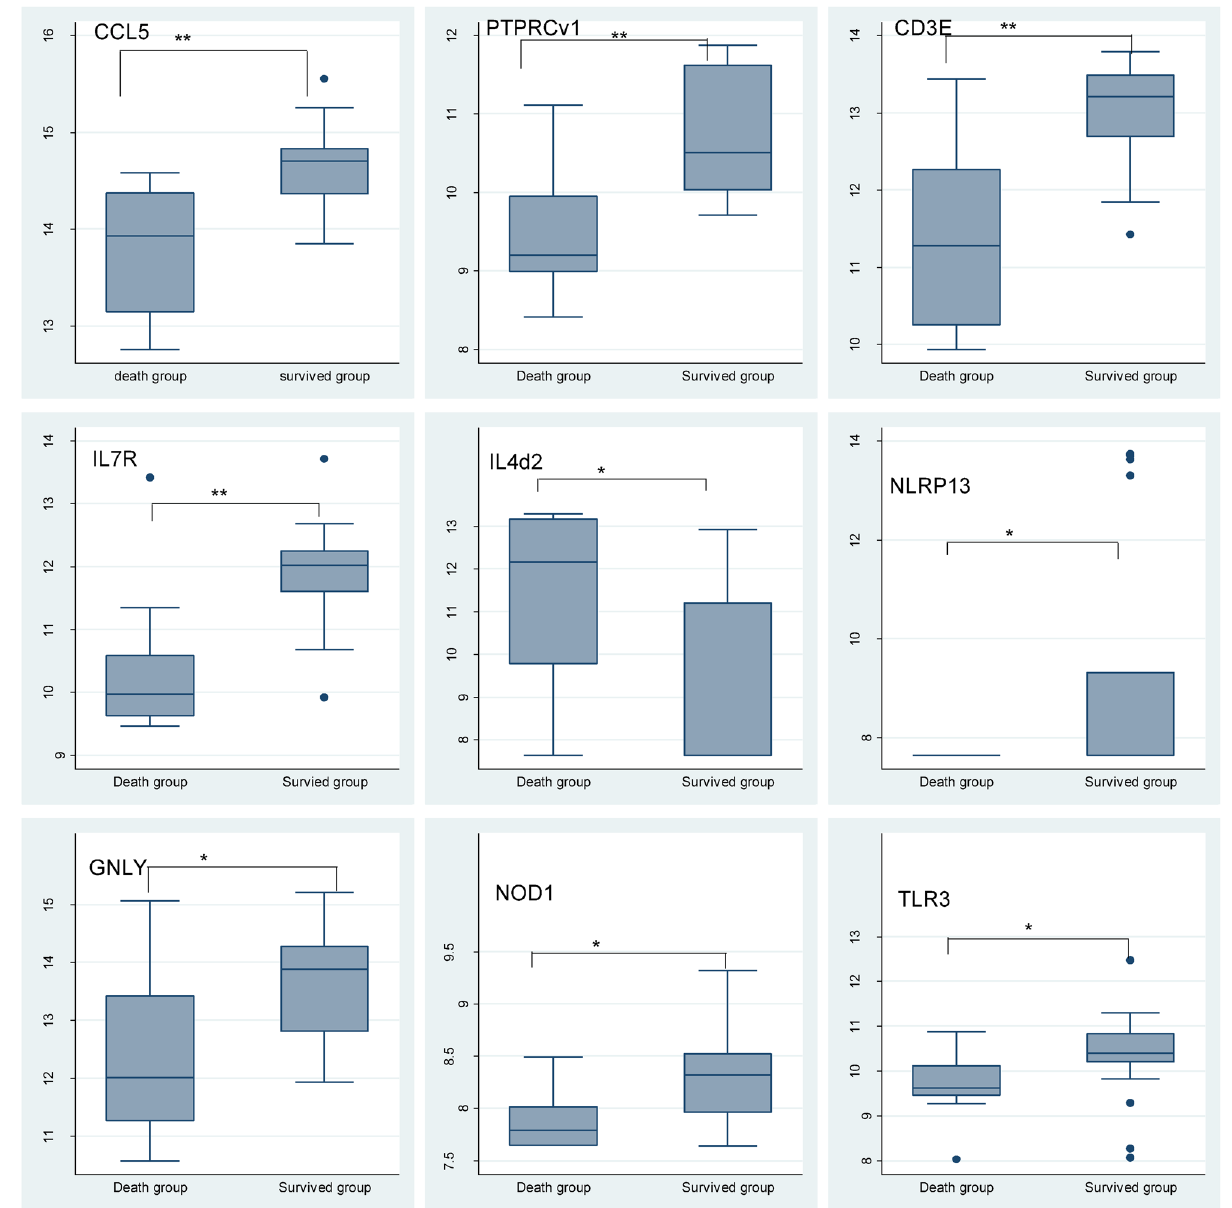
Figure 3. Gene expression profiles of signature genes. Median gene expression levels (peak areas normalized to GAPDH and log2-transformed) of the indicated genes are shown as box-and-whisker plots (5–95 percentiles). Significant differences between study groups were determined using Wilcoxon Mann–Whitney test. Shown are individual genes that were found to have the best discriminatory power to distinguish between death groups versus survival groups. (*P-value ≤ 0.05, **P-value ≤ 0.01, ***P-value ≤ 0.001, ****P-value ≤